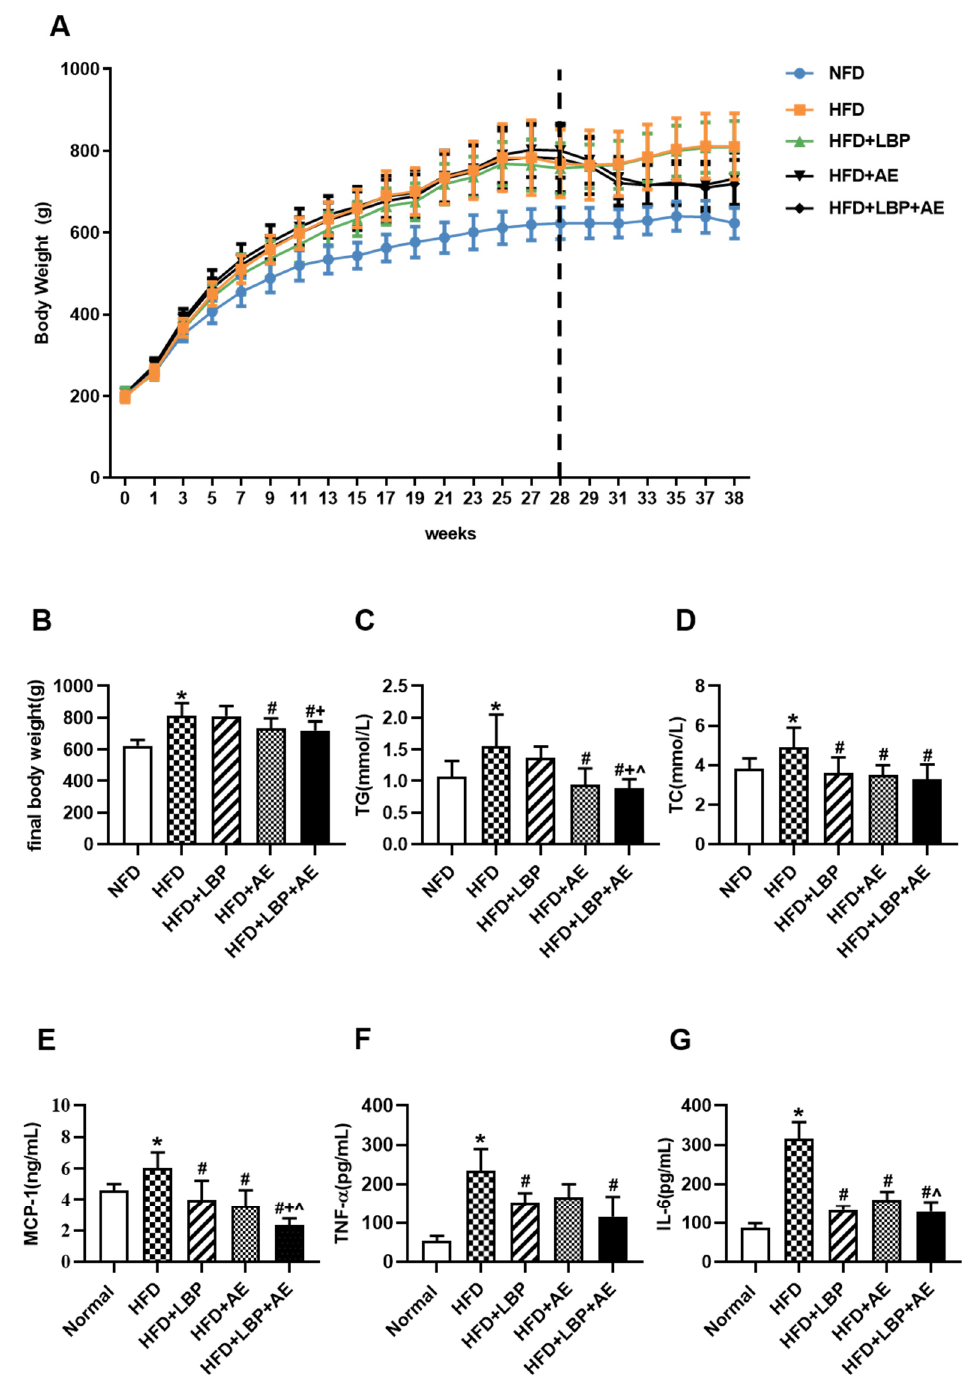
Figure 3. LBP plus AE reduced body weight, serum lipid as well as inflammation levels. ( A ) Body weight throughout the 38-week period. ( B ) Final body weight. ( C ) Serum levels of TG. ( D ) Serum levels of TC. ( E ) Serum levels of MCP-1. ( F ) Serum levels of TNF- α . ( G ) Serum levels of IL-6. * p < 0.05 vs. the NFD group. # p < 0.05 vs. the HFD group. + p < 0.05 vs. the HFD plus LBP group. ^ p < 0.05 vs. the HFD plus AE group. Lipid Metabolism element-binding protein 1c (SREBP1c) are genes related to de novo lipogenesis (DNL).